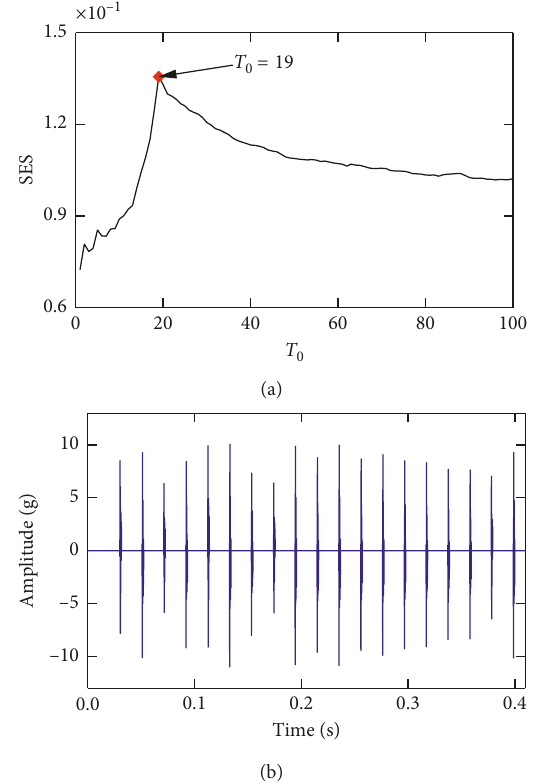
based on SES: (a) 0